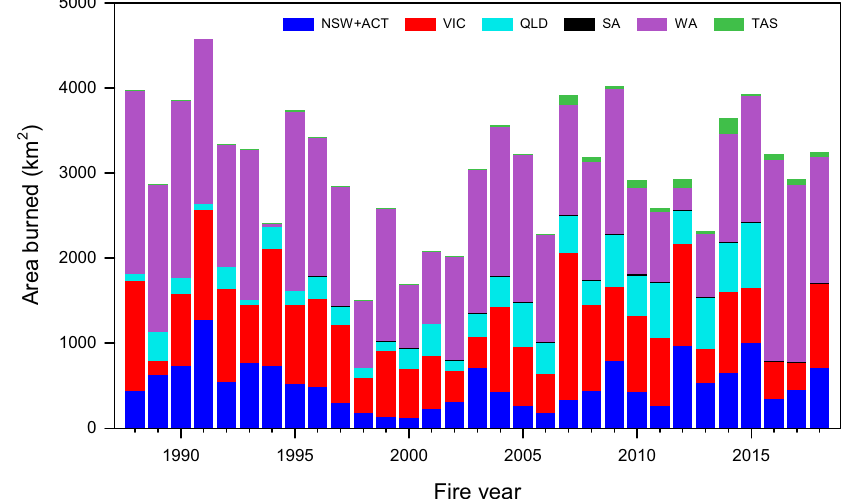
Fig. 7 Area of prescribed burning in forest ecosystems. Data from the States and Territories fi re histories for New South Wales and Australian Capital Territory (NSW + ACT, dark blue), Victoria (VIC, red), Queensland (QLD, light blue), South Australia (SA, black), Western Australia (WA, violet) and Tasmania (TAS, green). Queensland data for 2016-2019 is not available.